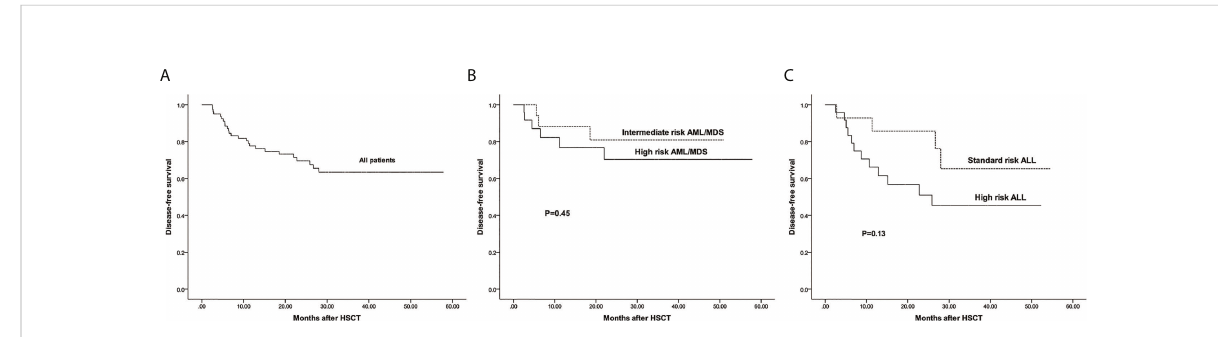
FIGURE 6 The estimated probability of disease free survival (DFS). (A) DFS in all patients. (B) DFS between intermediate risk AML/MDS and high risk AML/ MDS. (C) DFS between standard risk ALL and high risk